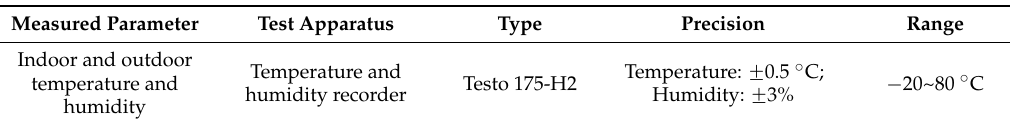
Table 1. Test apparatus and parameters.